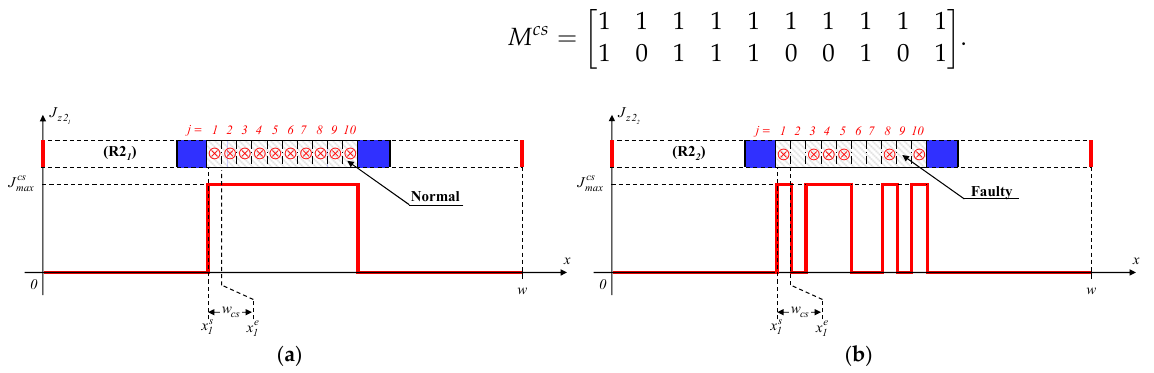
J in (R2 2 ). in (R2 2 2 z2 2